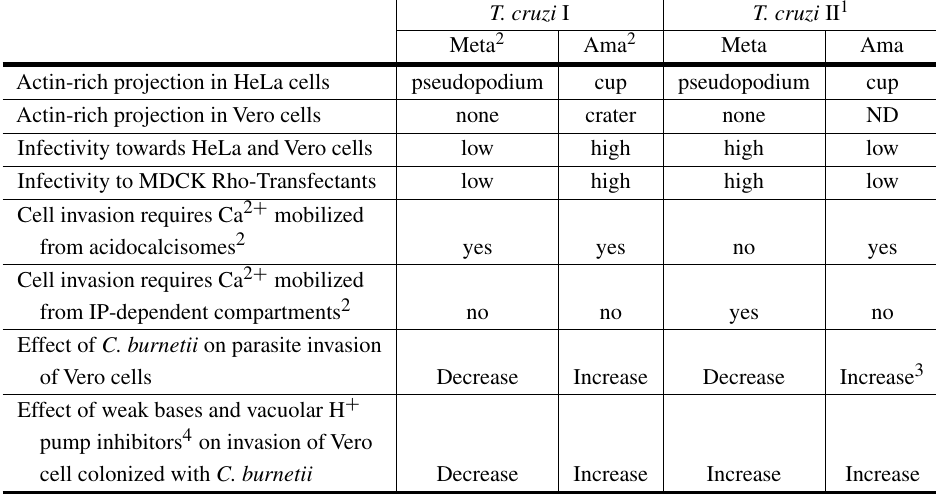
Invasion of cultured cells by T. cruzi I and II infective